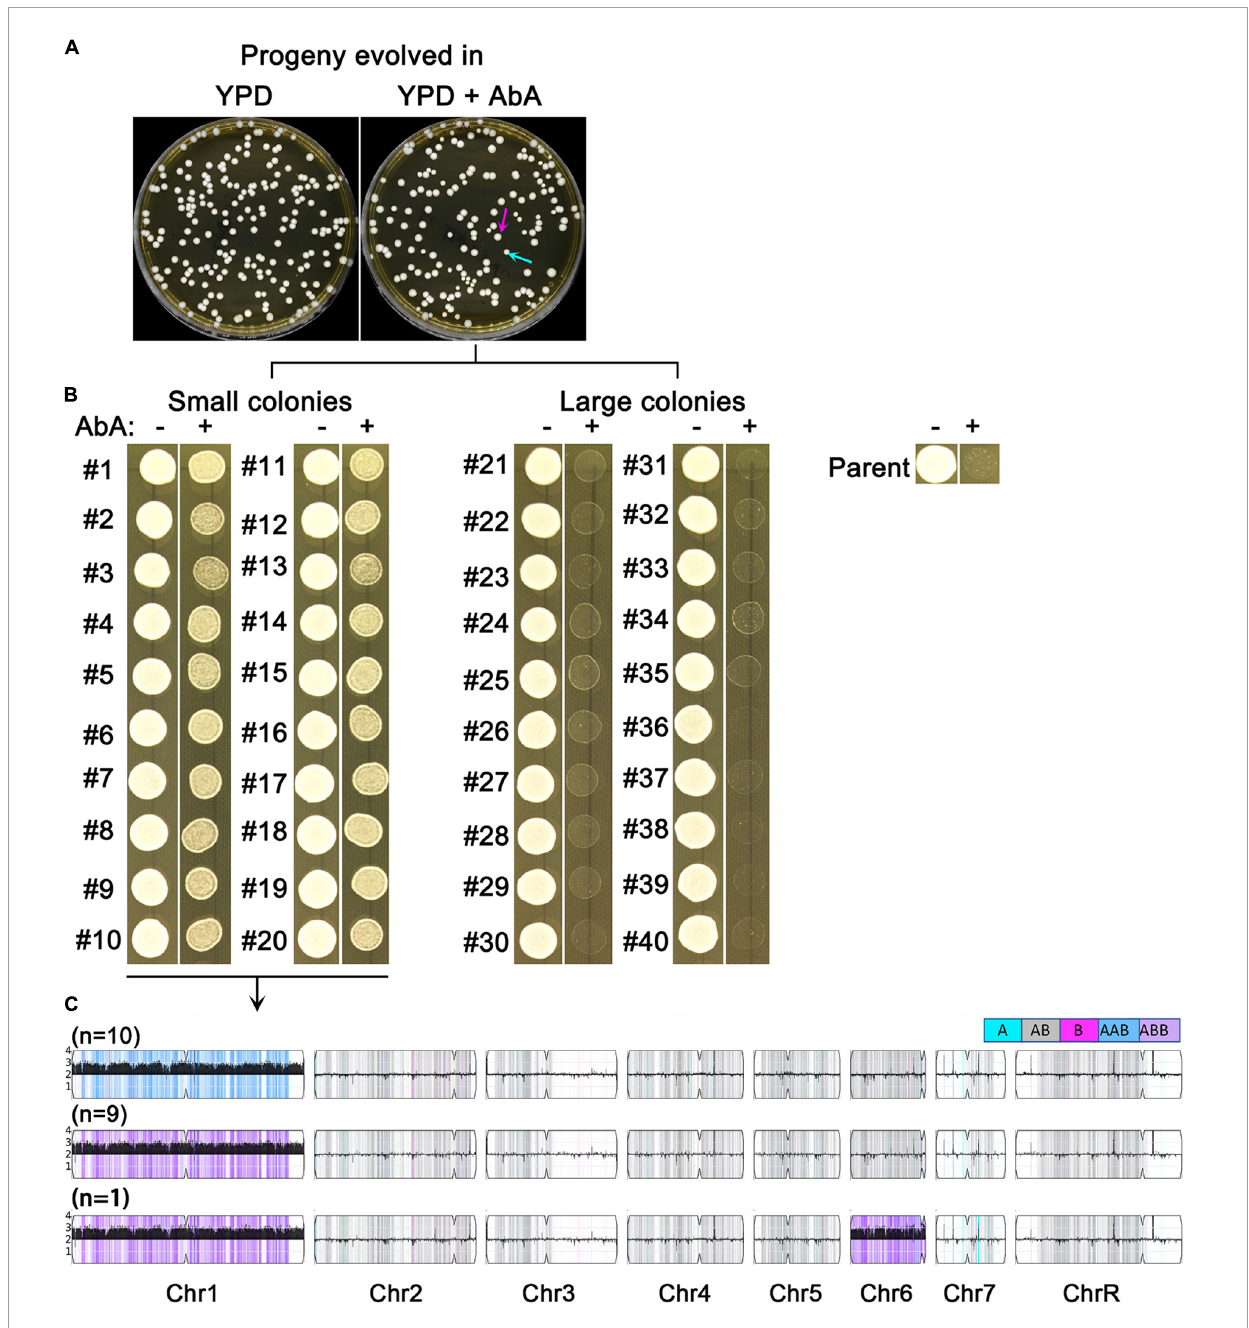
FIGURE3 Sub-inhibitory amount of aureobasidin A selects aneuploid mutants. SC5314 was grown in YPD broth supplemented with or without 5 ng/ml aureobasidin A. After 48 h, the cultures were washed and diluted using distilled water. Approximately 200 cells were spread on YPD. The plates were photographed after 24 h incubation at 37 ◦ C. Cyan arrow indicates small colonies and magenta arrow indicates large colonies (A) . Randomly 20 small and 20 large colonies from the drug evolved culture were tested for resistance to aureobasidin A (B) , and all the 20 resistant mutants were sequenced (C)